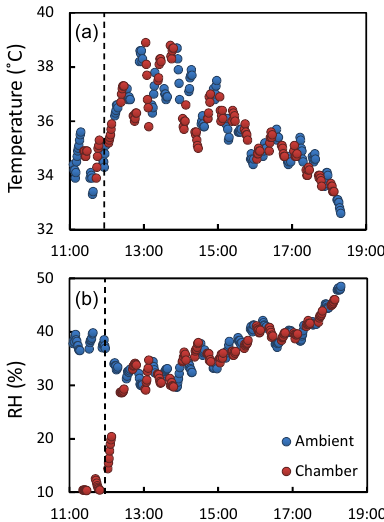
Figure 5. Temperature (a) and RH (b) measured inside the QUAL- ITY chamber (Red circles) and in the ambient air (blue circles). The temperature and RH were measured by probes placed in the sampling tube adjacent to the chamber. The vertical dashed lines denote the time when the ambient air started to be pulled through the bottom flow chamber and the ambient gases began to pass into the upper reaction chamber.